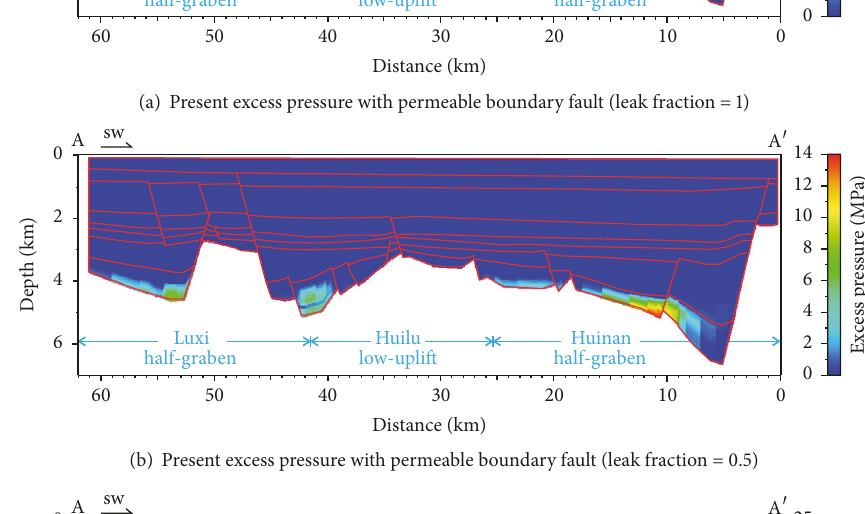
rock is much higher than that of the Enping source